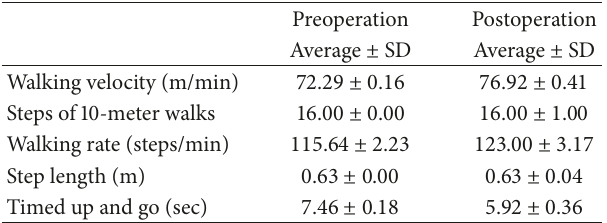
Table 1: Pre- and postoperative walking speed, walking rate, and timed up and go (TUG)